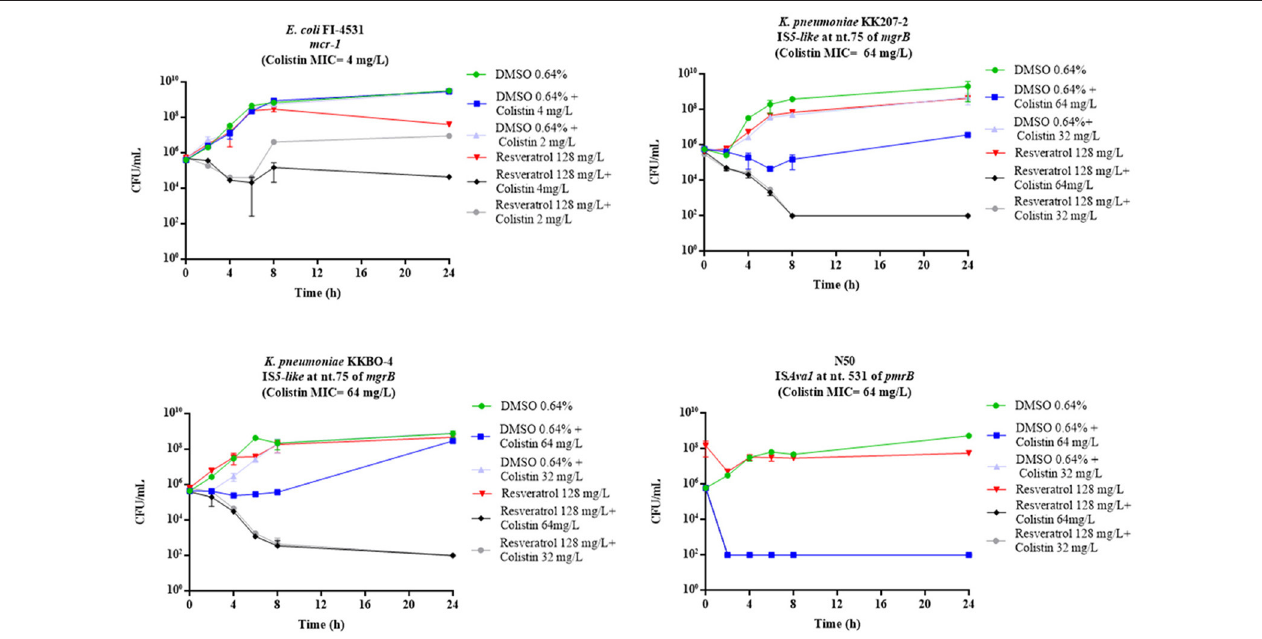
FIGURE 2 | Time-kill assays with colistin at 0.5 or 1 X MIC in combination with resveratrol 128 mg/L, in the strains in which colistin 2 mg/L plus resveratrol 128 mg/L yielded a bacteriostatic effect. Data are mean values from the results of two independent experiments, and the error bars represent standard deviations. The lowest number of CFU (detection limit) that can be detected by the method used is 1E + 02 CFU/mL.